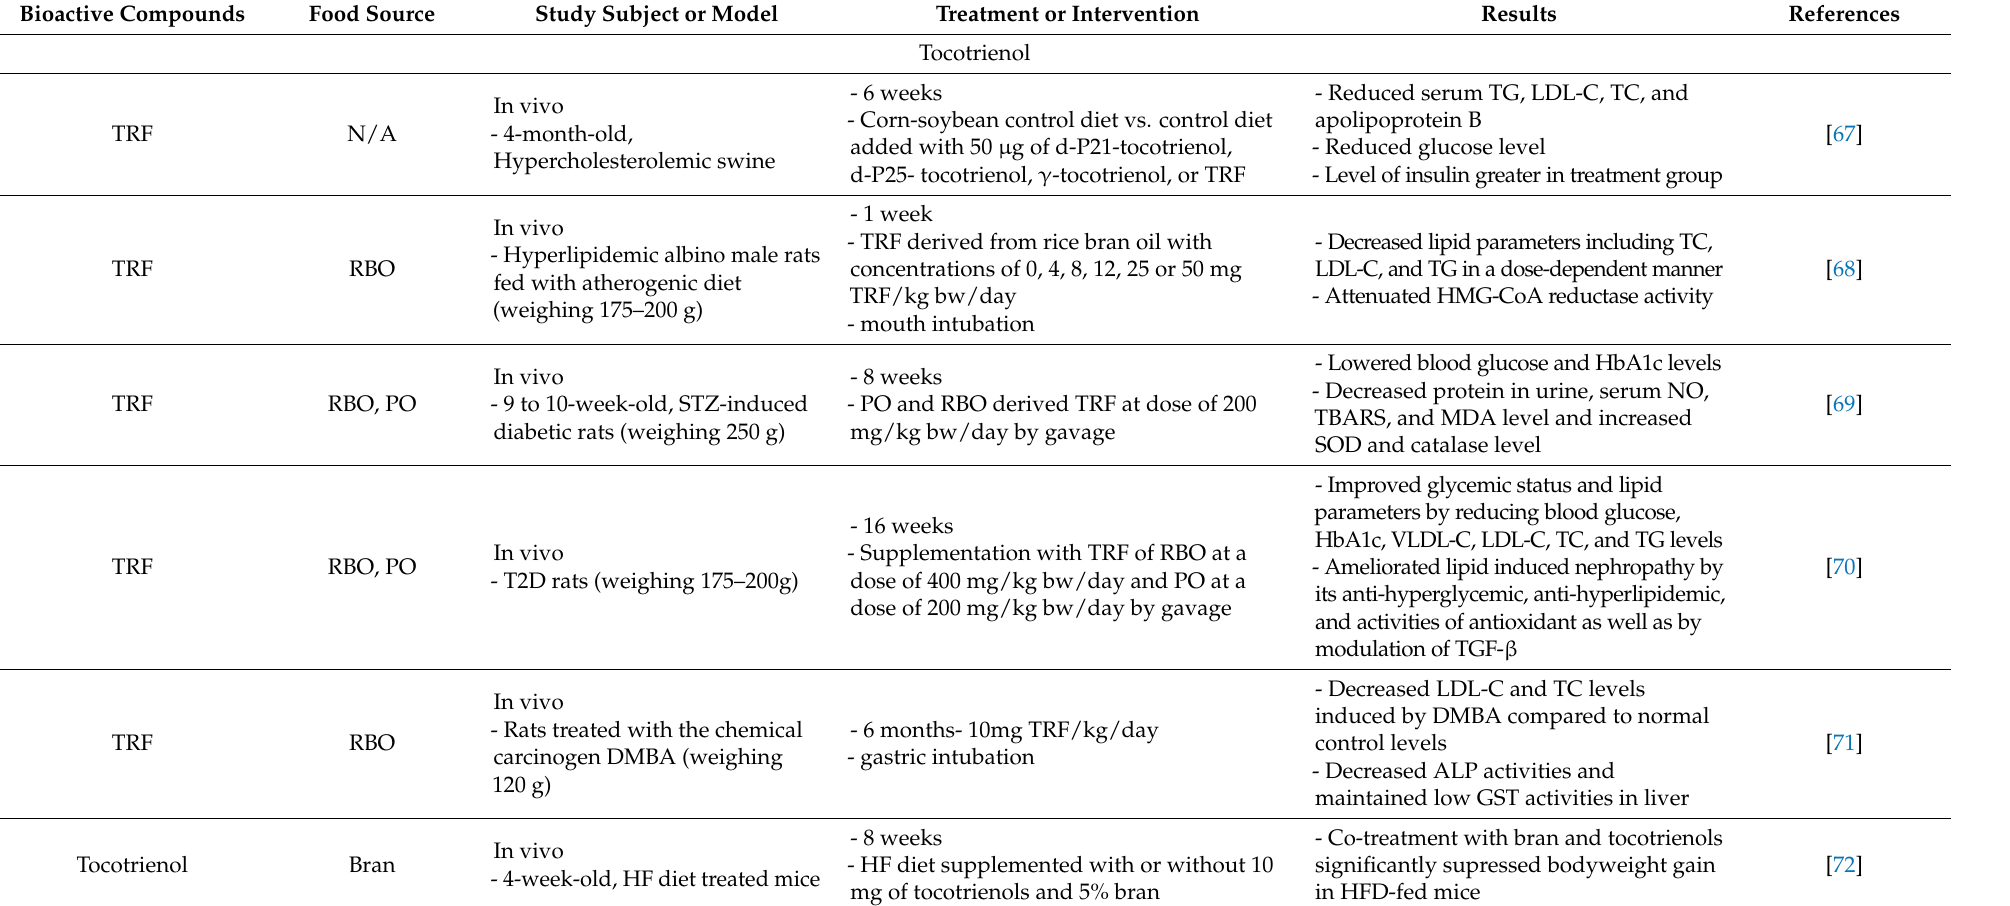
Table 3. Effects of vitamin E on cardiovascular and metabolic